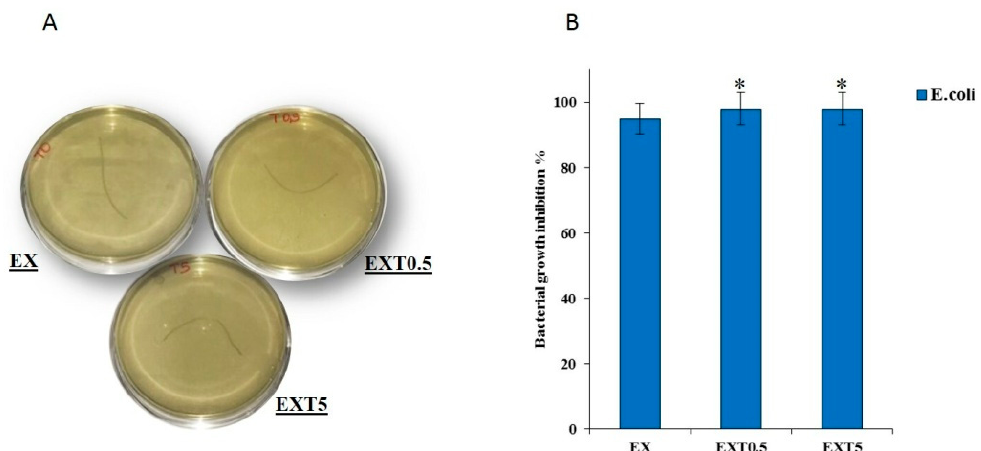
Figure 9. The images of E. coli with the EX, EXT0.5 and EXT5 threads ( A ). The bacteria growth inhibition of all samples. Values are the mean standard deviation (SD) of measurements carried out on the samples analyzed three times. The means and SDs are shown. * p < 0.05 vs. the bacteria control treated without threads ( B ).